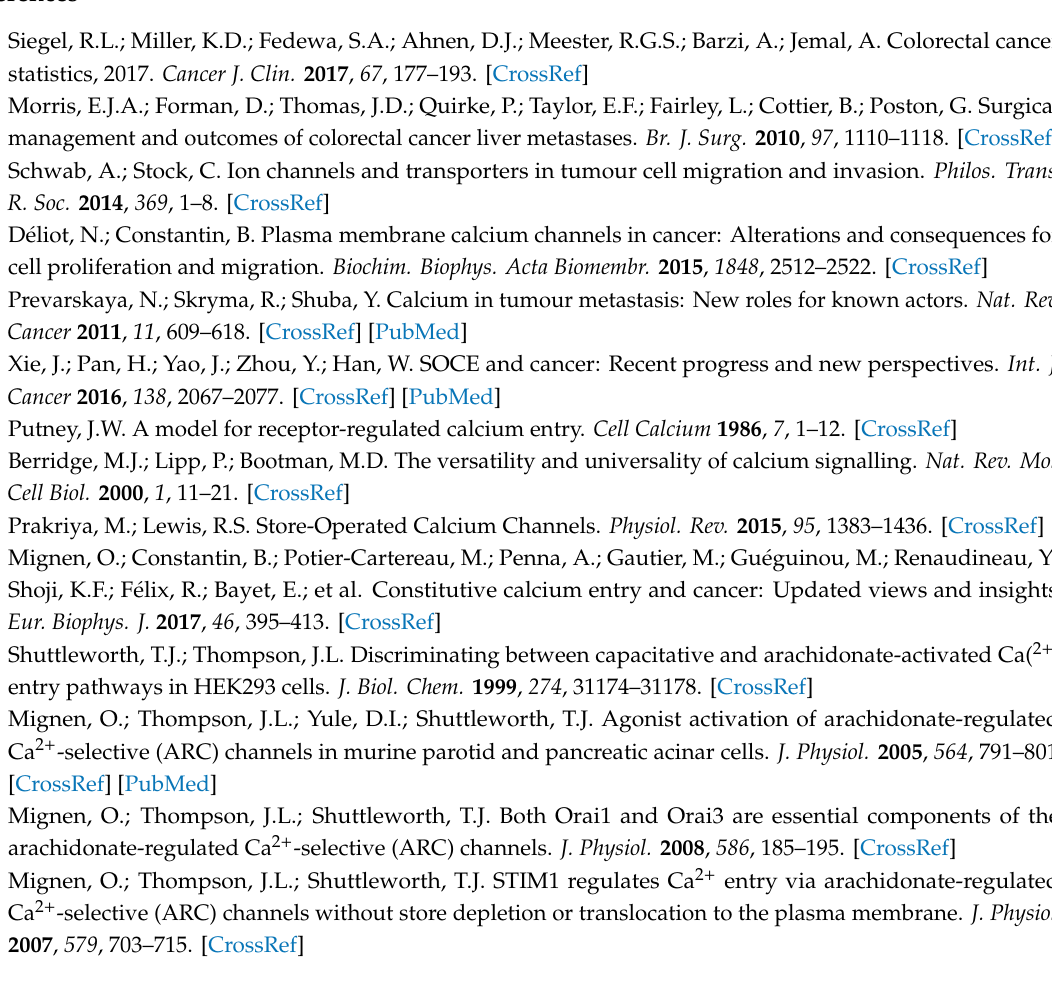
Table S1: Symbols, names and functions of the selected genes, Table S2: Comparison of gene expression levels in normal mucosa versus tumor samples in TCGA dataset, Table S3: Comparison of gene expression levels in normal mucosa versus tumor samples in GSE39582, Table S4: Comparison of gene expression levels between proximal and distal / rectal tumors in TCGA dataset, Table S5: Comparison of gene expression levels between proximal and distal tumors in GSE39582 dataset, Table S6: Comparison of gene expression levels between N0 and N + (lymph node metastatic) tumors in TCGA dataset, Table S7: Comparison of gene expression levels between N0 and N + (lymph node metastatic) tumors in GSE39582 dataset, Table S8: Comparison of gene expression levels between stage IV and stages I + II + III in TCGA dataset, Table S9: Comparison of gene expression levels between stage IV and stages I + II + III in GSE39582 dataset, Table S10: Univariate analysis of OS and EFS in TCGA dataset, Table S11: Univariate analysis of OS and RFS in GSE39582